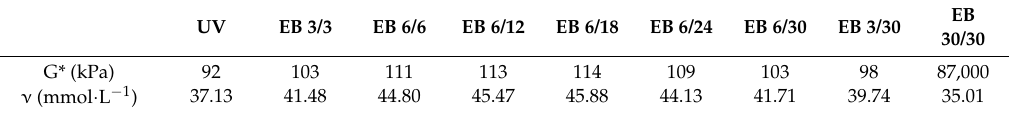
Table 1. Crosslinking density values calculated from the dynamic moduli.